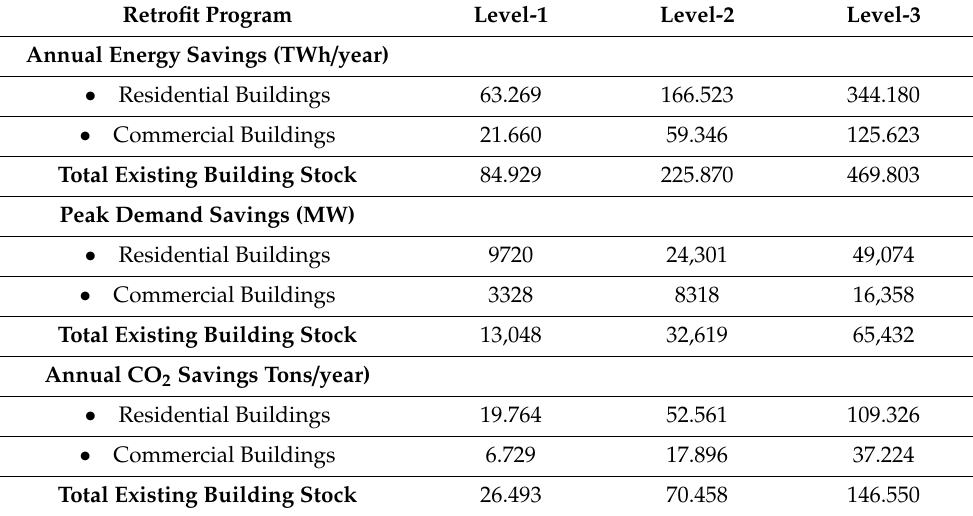
Table 23. The energy and environmental benefits for three levels of building energy e ffi ciency retrofit programs for the Arab region *